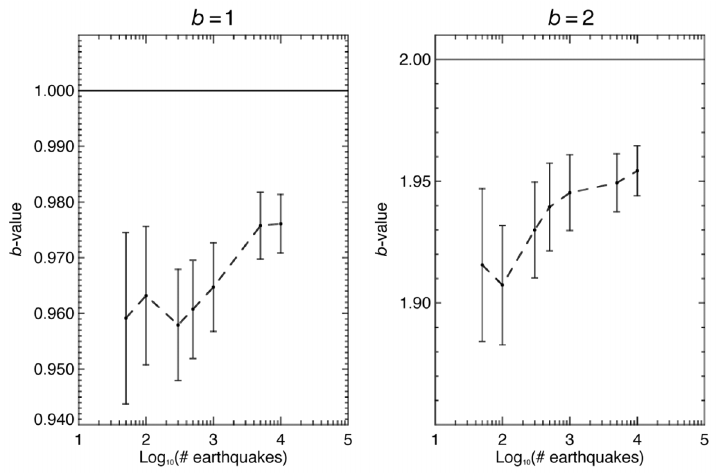
Fig. 1. Average of b t (dashed line) calculated through cumulative LS technique in 1000 synthetic catalogs, as a function of the catalog size, for the cases b = 1 ( left ) and b = 2 ( right ). At each average is attached the 95% con- fidence interval. The solid line represents the true b